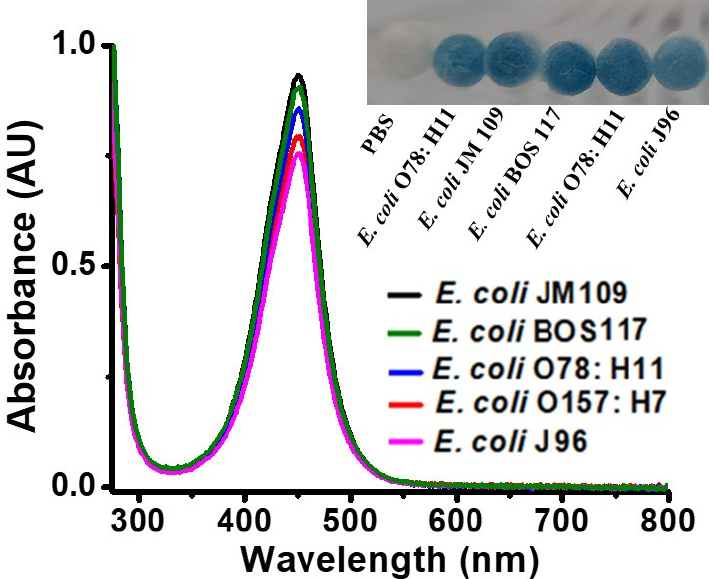
Figure 4. UV–Vis absorption spectra of the samples (0.2 mL) containing different E. coli strains (OD 600 of ~1), obtained after reaction with H 2 O 2 (11.2 mM) in the presence of TMB (1.25 mM) at pH 3, followed by the addition of sulfuric acid (2 M, 2 µL) to stop the reaction. (Inset) shows the photograph of the cotton swabs containing E. coli strains (OD 600 of ~1) obtained after reaction with H 2 O 2 (11.2 mM) in the presence of TMB (1.25 mM) at pH 3. The reaction was conducted at room temperature (~25 °C).